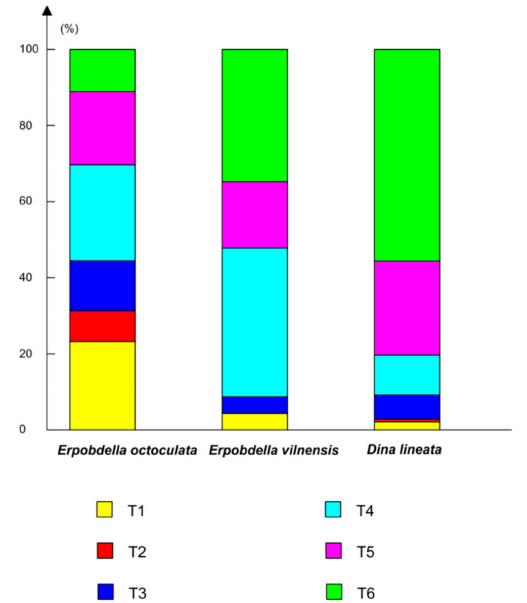
Figure 4. The distribution of the analyzed species with respect to the di ff erent waterbody